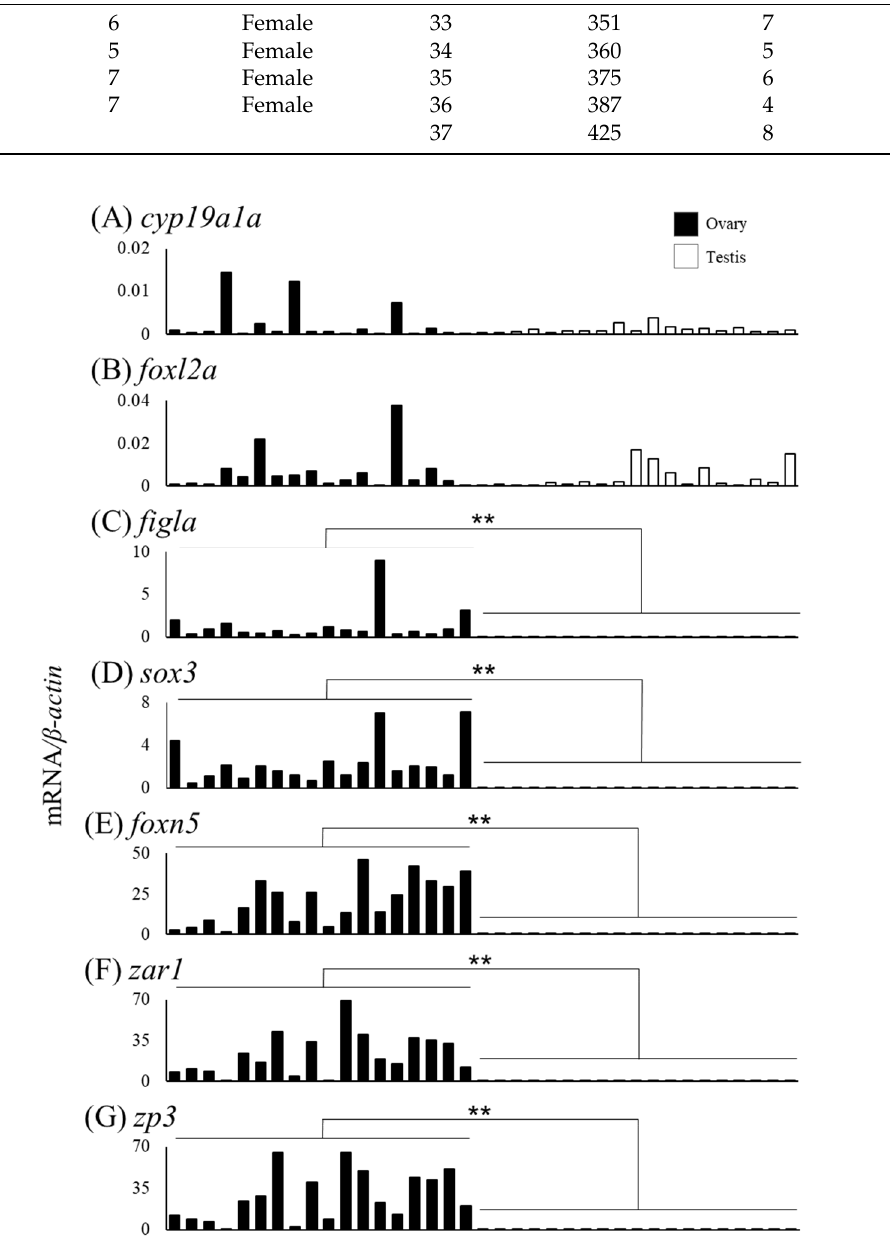
Figure 6. Messenger RNA levels of sex differentiation-related genes ( cyp19a1a , foxl2a , figla , sox3 , foxn5 , zar1 and zp3 ) in the ovaries and testes of the wild Japanese eel Anguilla japonica. ( A ) cyp19a1a , ( B ) foxl2a , ( C ) figla , ( D ) sox3 , ( E ) foxn5 , ( F ) zar1 and ( G ) zp3 mRNA levels in the ovary and testis. Each column indicates mRNA levels normalized against β -actin expression. TL in the ovary and testis (Nos. 1–37); for details, refer to Table 3. ** P < 0.01.